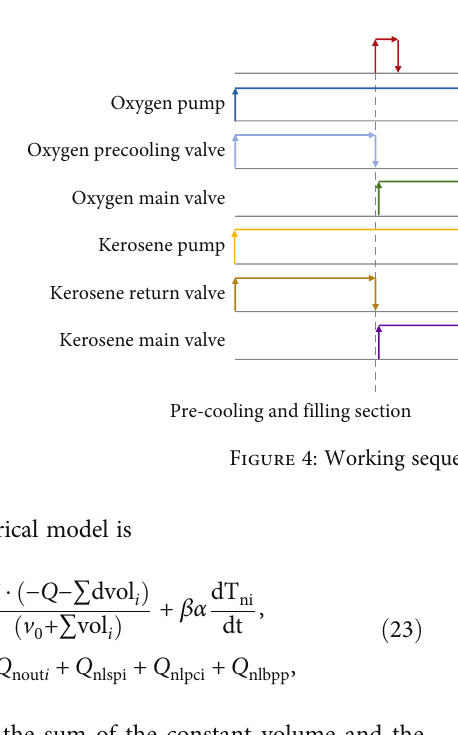
Figure 3: The head structure of the thrust chamber.